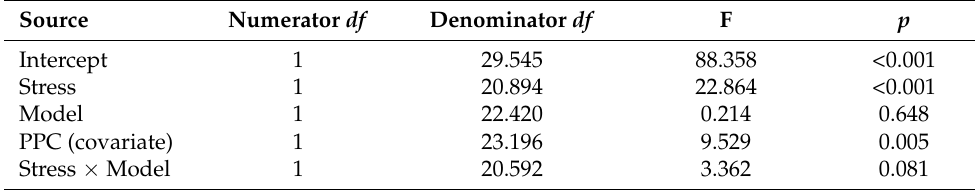
Table 4. For the group with childhood apraxia of speech (CAS) only, test of fixed effects exploring the influence of stress type (SW, WS), and model (single, multiple) on tool–human percent agreement for lexical stress classification, accounting for the effect of speech disorder severity (i.e., percent phonemes correct,